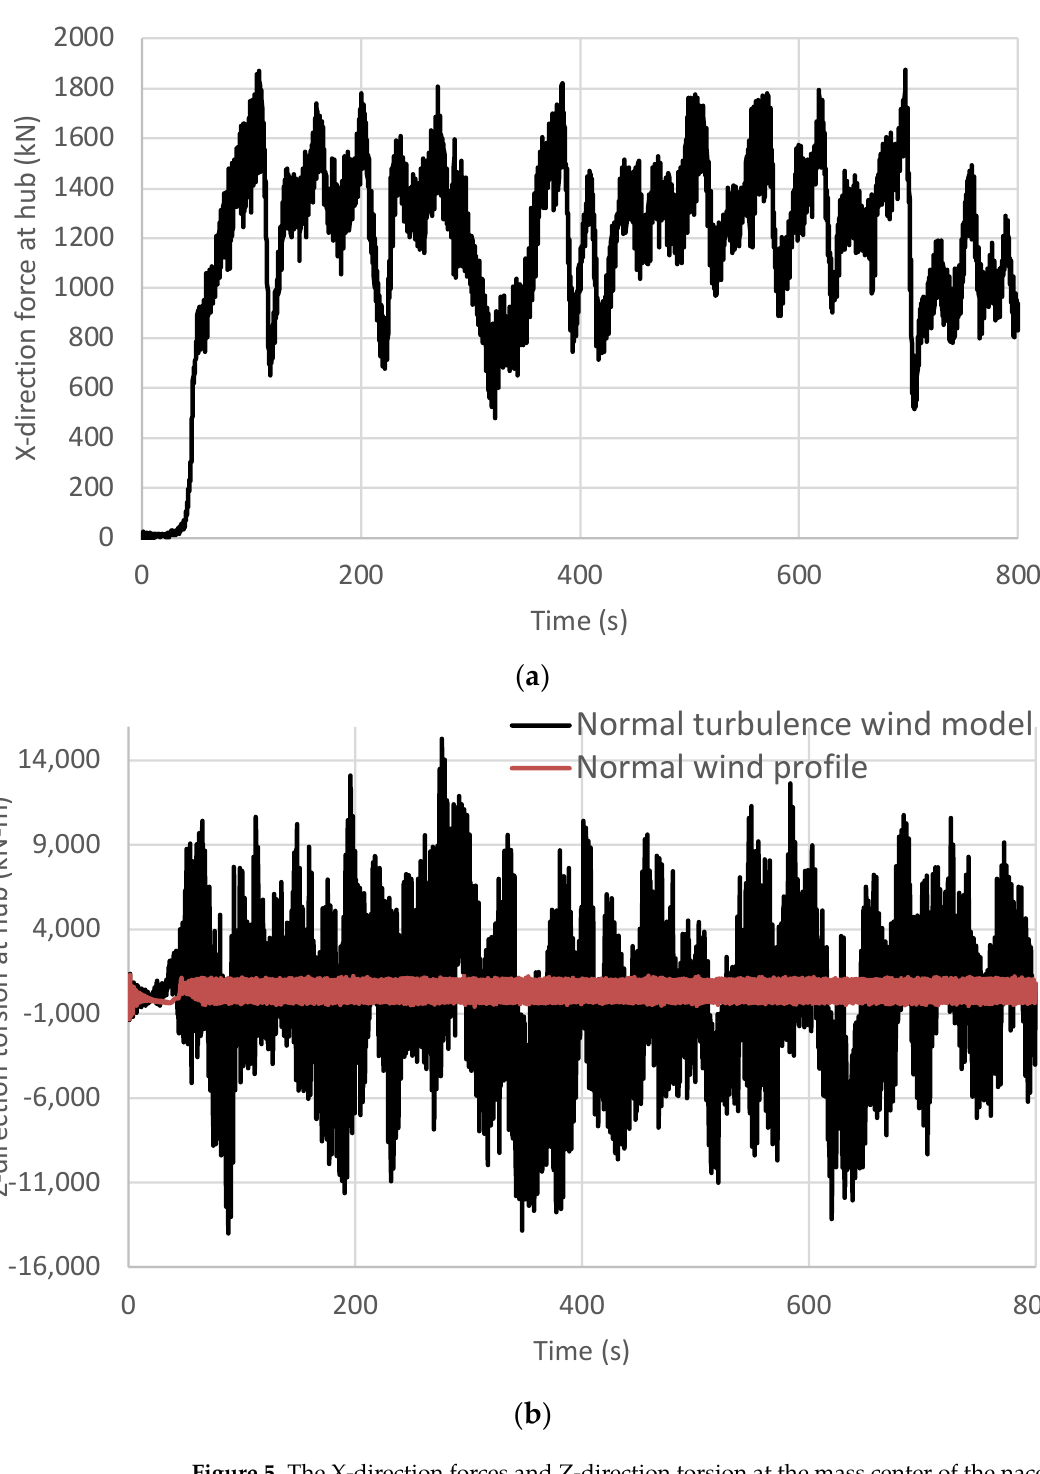
Figure 5. The X-direction forces and Z-direction torsion at the mass center of the nacelle under the normal turbulence wind model (DLC 1.1) and the normal wind profile (DLC 2.5) with the average wind speed of 11 m/s using the FAST simulation. ( a ) X-direction forces (Normal turbulence wind model); ( b ) Z-direction torsion.